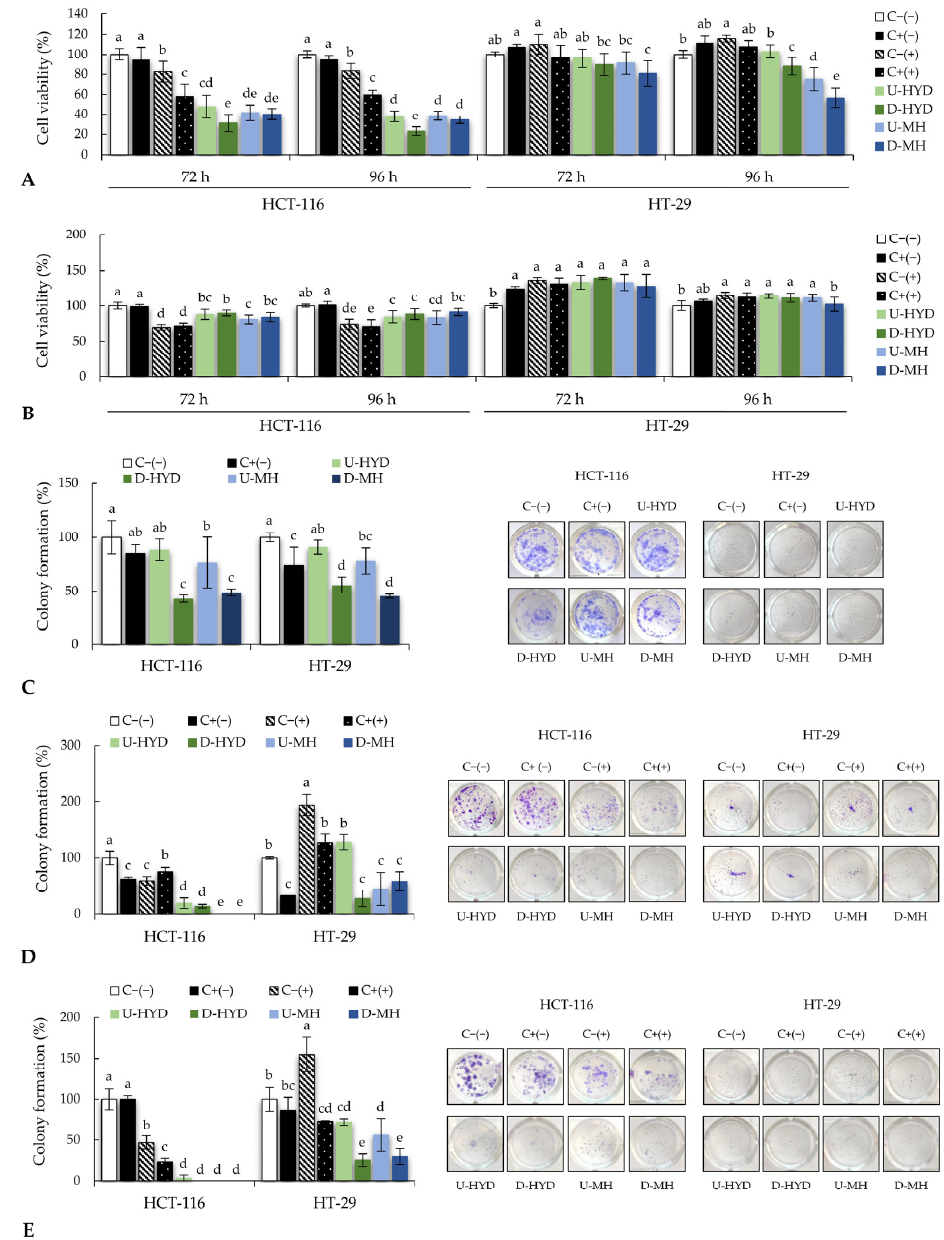
Figure 3. Antiproliferative effect of spent media from ( A ) RAW264.7 and ( B ) THP-1 cells exposed to undigested (U) or digested (D) HYD and MH at 0.5 mg/mL in HCT-116 and HT-29 cells for 72 and 96 h (n = 8). Relative percentage of HCT-116 and HT-29 colonies treated with ( C ) WB samples at 0.5 mg/mL, spent media from ( D ) RAW264.7, and ( E ) THP-1 cells stimulated with WB samples at 0.5 mg/mL (n = 4). Right side of ( C , D ): representative images from respective human colon cancer cells and treatments. Mean values represented as bars, and standard deviations represented as error bars. Di ff erent lowercase le tt ers show signi fi cant di ff erences among experimental groups (one-way ANOVA, post hoc Duncan’s test, p ≤ 0.05). Abbreviations: colon cancer cells treated with growth media without LPS (C − ( − )); with growth media with LPS (1 µg/mL) (C+( − )); with non-stimulated macrophage supernatant (C − (+)); with LPS-stimulated macrophage supernatant (C+(+)); undigested WB hydrolysate (U-HYD); digested WB hydrolysate (D-HYD); undigested mousse with WB hydrolysate (U-MH); and undigested mousse with WB hydrolysate (U-MH).